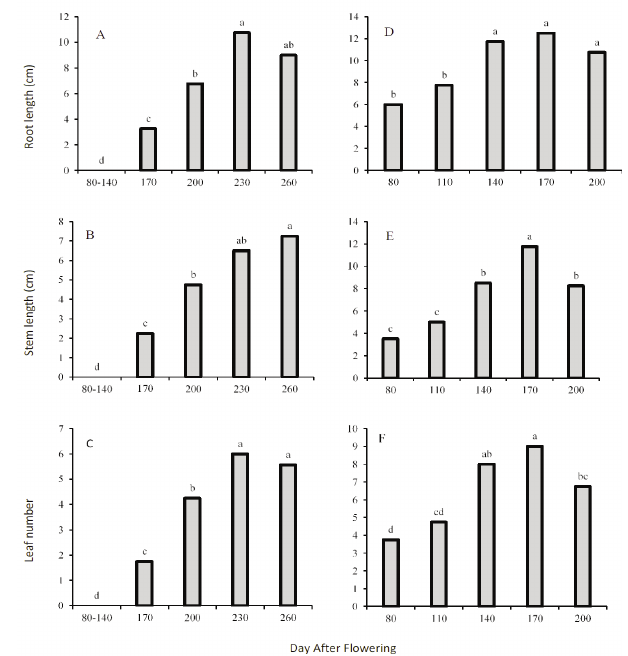
Fig. 4 ­ Effect of harvest time on seedlings root length, stem length and leaf number of sour orange (A­C) and Mexican lime D­F) under in vitro conditions. Means with the same letter are not significantly different at 1% pro­ bability using LSD